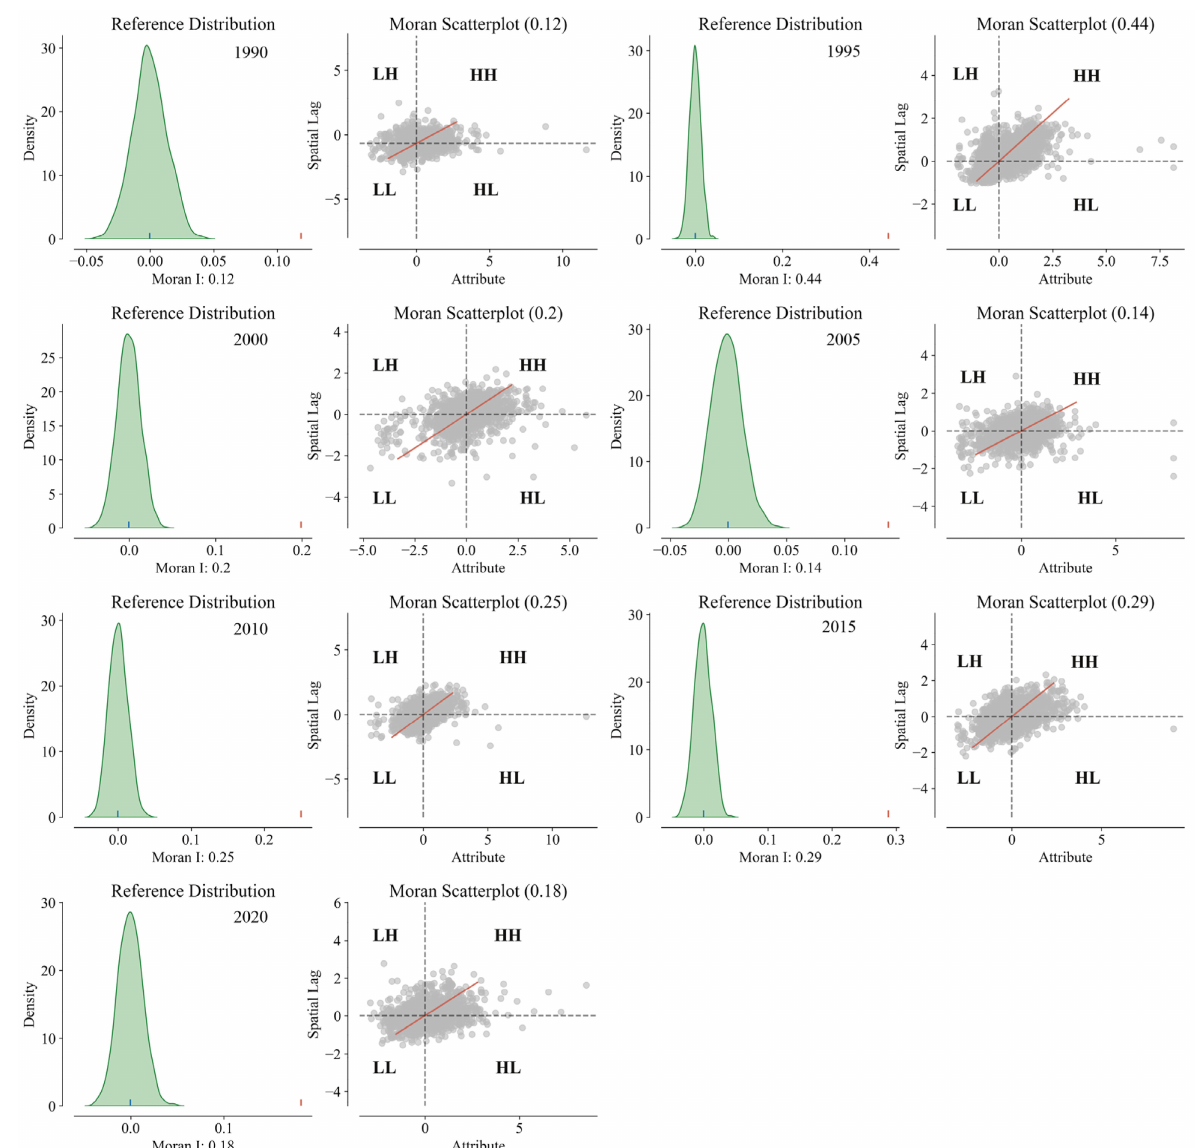
Figure 8. Global Moran’s I and Moran scatterplot of CS in 1990, 1995, 2000, 2005, 2010, 2015 and 2020. Quadrant 1 (HH) is a high-value area surrounded by other high-value areas. Quadrant 2 (LH) is a low-value area surrounded by high-value areas. Quadrant 3 (LL) is a low-value area surrounded by low-value areas. Quadrant 4 (HL) is a high-value area surrounded by low-value